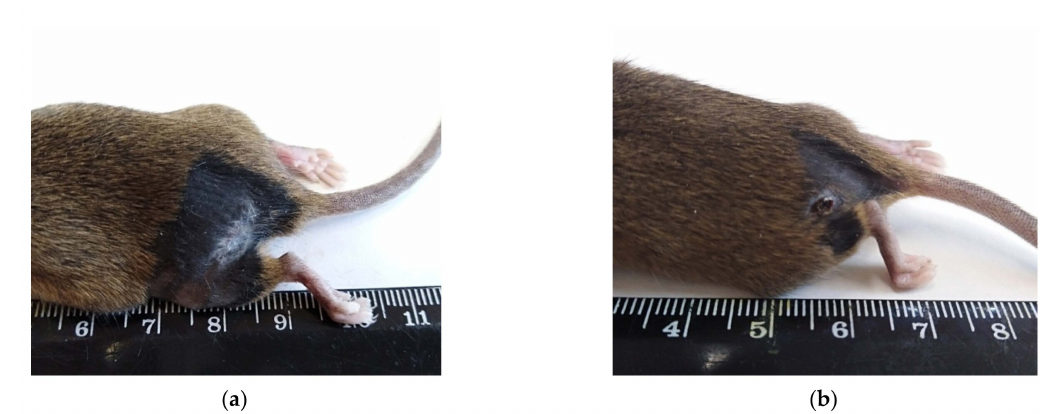
Figure 3. Healing of the skin in the area of the photodynamic exposure in the experimental groups on the 21st day after PDT: ( a ) Healing of the skin with scar formation. Macrophoto; ( b ) Healing of the skin with the formation of a scab. Macrophoto.